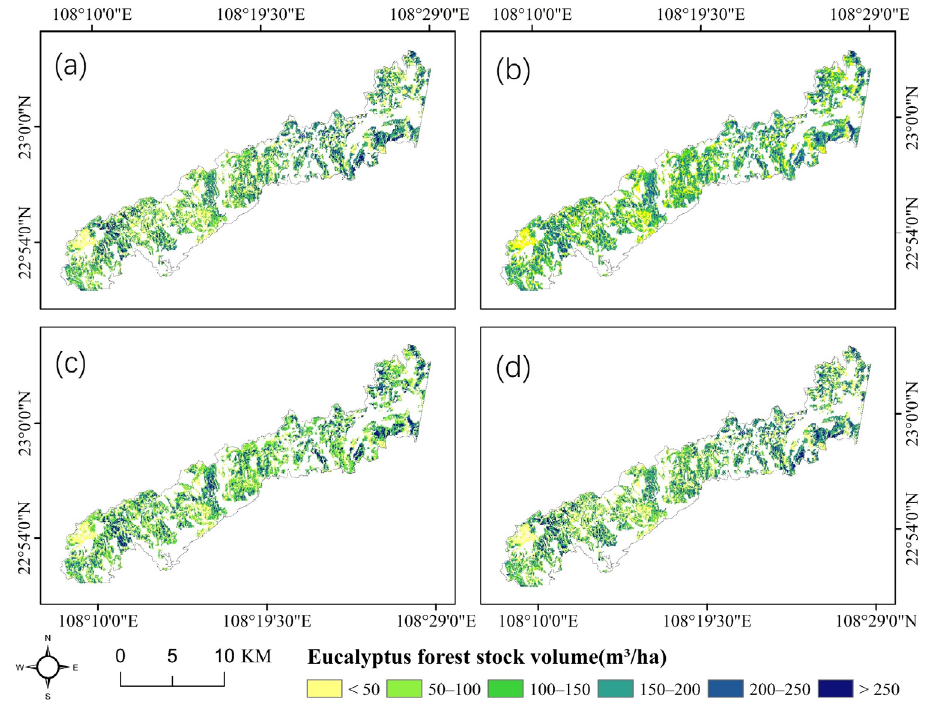
Figure 11. The map of FSV in planted eucalyptus forest using four models and variable set 4 from composite LC8 images: ( a – d ) is mapped FSV using SVM, RF, KNN, and MLR, respectively.